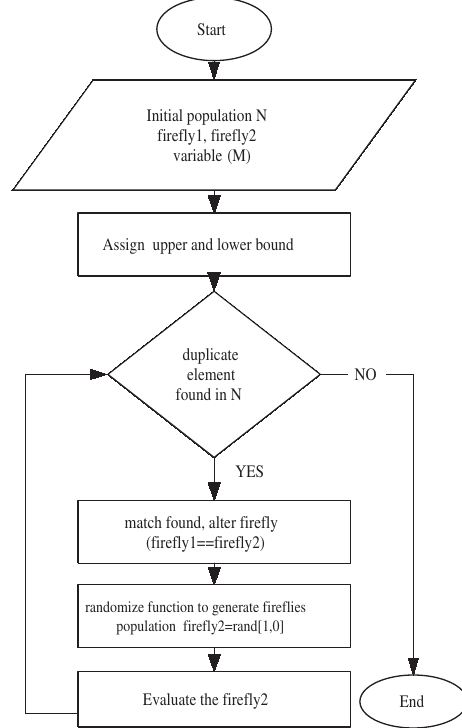
Figure 4. The flowchart of duplication removal in